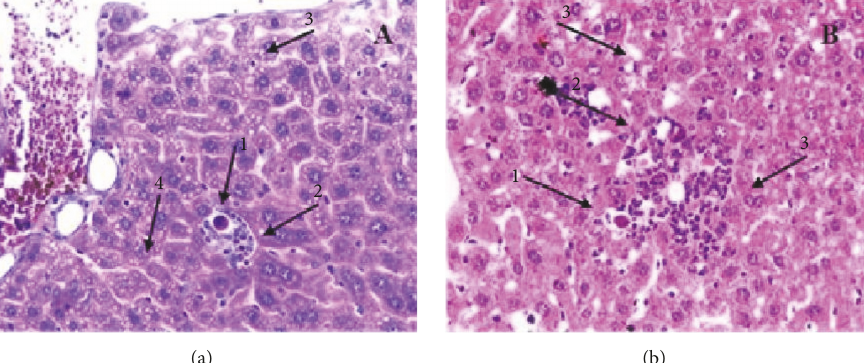
Figure 1: Liver tissue presenting apoptosis (1) , extramedullary hematopoiesis (2) , hepatic steatosis (3) , and congestion (4) in animals subject to a dose of 500 mg/kg of K. brasiliensis in acute toxicity (A) and hepatic tissue presenting apoptosis (1) , extramedullary hematopoiesis (2) , and hydropic and hepatic degeneration (3) in the animal subject to a dose of 1000 mg/kg of the extract of K. brasiliensis in the acute toxicity evaluation (B)